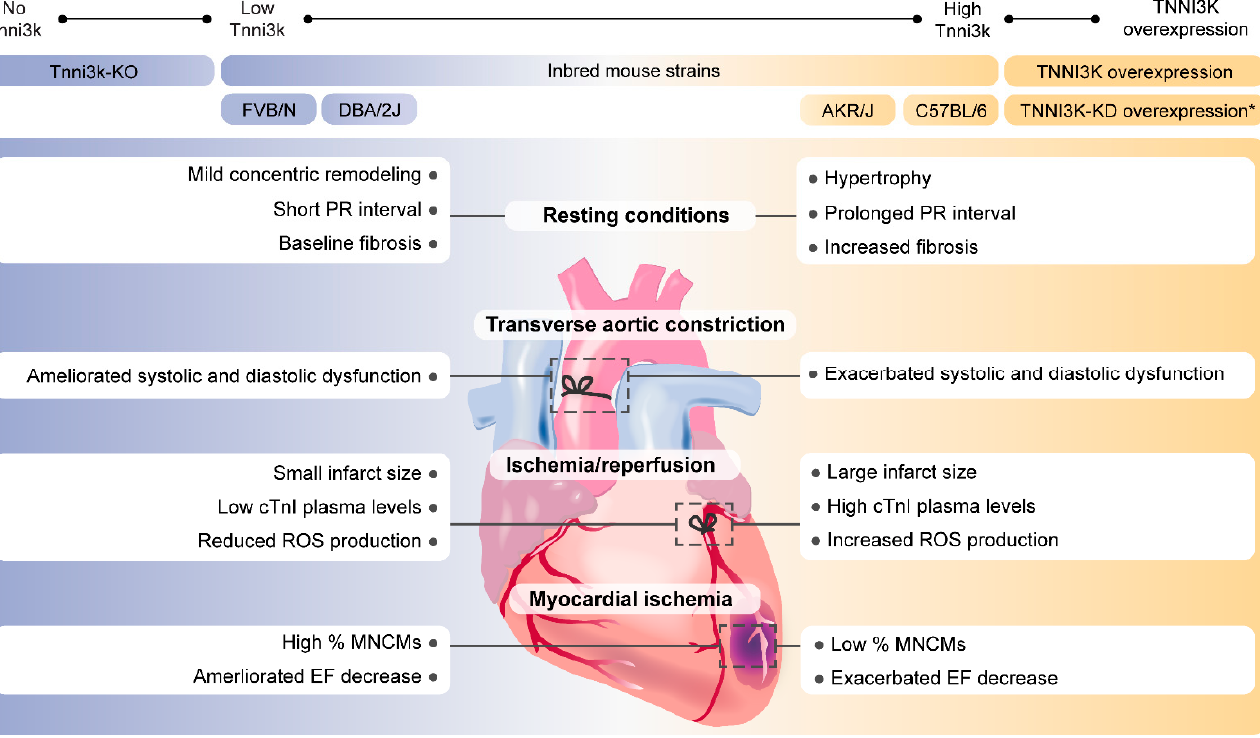
Figure 2. Summary of cardiac phenotypes in mouse models generated to study the function of TNNI3K. The upper panel shows the Tnni3k/TNNI3K overexpression mouse models and inbred mouse strains with their relative Tnni3k expressions. The lower panel summarizes cardiac features in mice expressing relatively low (on the left) and high (on the right) Tnni3k levels in resting conditions, after TAC, I/R injury, or MI. cTnI: Troponin-I; EF: Ejection fraction, MNCMs: Mononuclear cardiomyocytes.